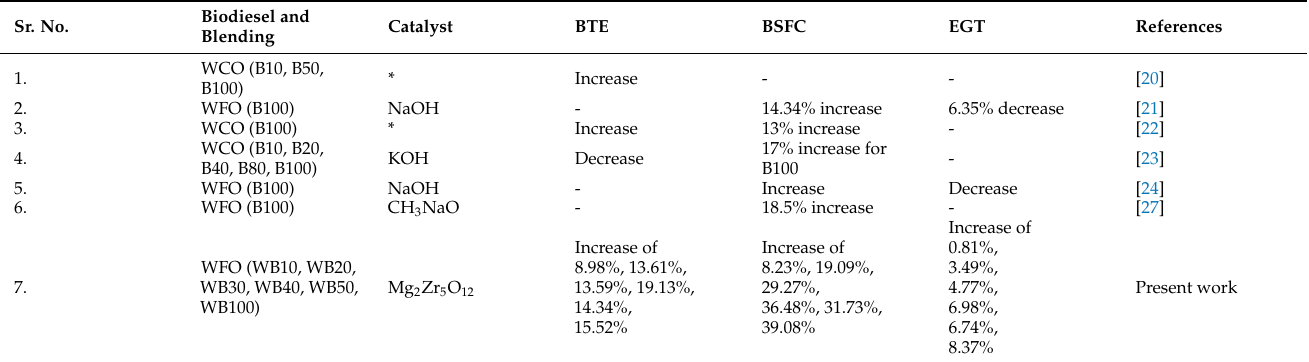
Table 4. Comparison of engine performance with respect to diesel fuel based on previous